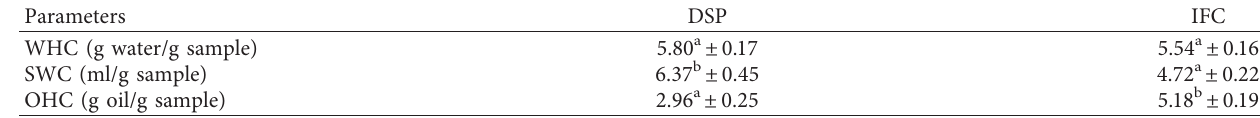
Table 3: Technofunctional properties of DSP and